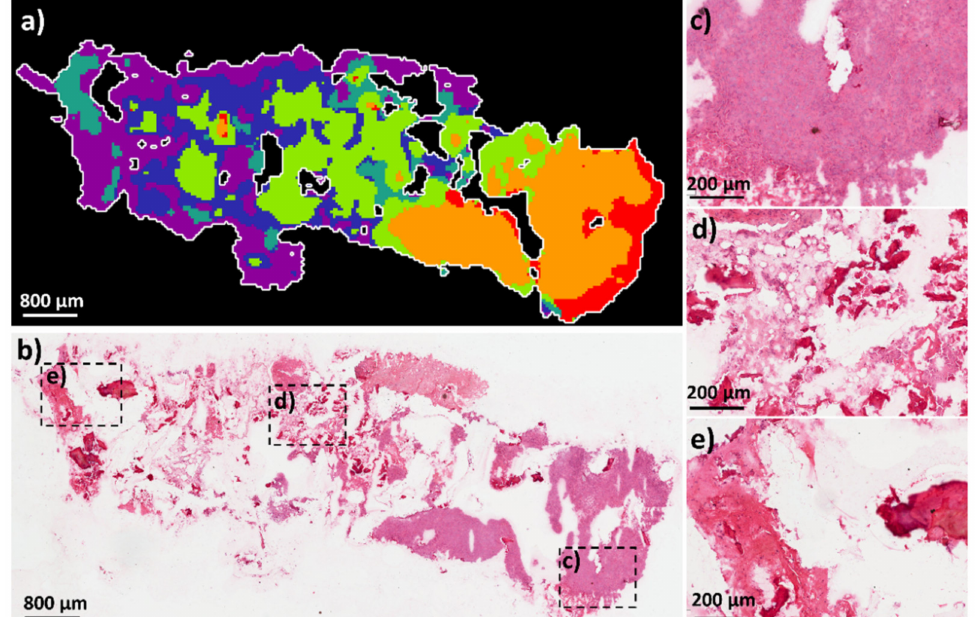
Figure 6. Spatial segmentation analysis of OS patient_882 tissue sample from metabolite data by DESI-MSI. ( a ) spatial segmentation of OS section highlighting heterogeneous clusters throughout tissue. Scale bar 800 µ m. ( b ) H&E of same OS tissue section after image analysis. Scale bar 800 µ m. Magnification of ROIs in H&E image: ( c ) solid tumour (corresponding to the orange cluster) at the right of the tissue; ( d ) region of medullary space with osteoid bone located focally (corresponding to the green and blue clusters); ( e ) lamellar bone located at the left of the tissue (corresponding to the sage green cluster). Scale bar 200 µ m.